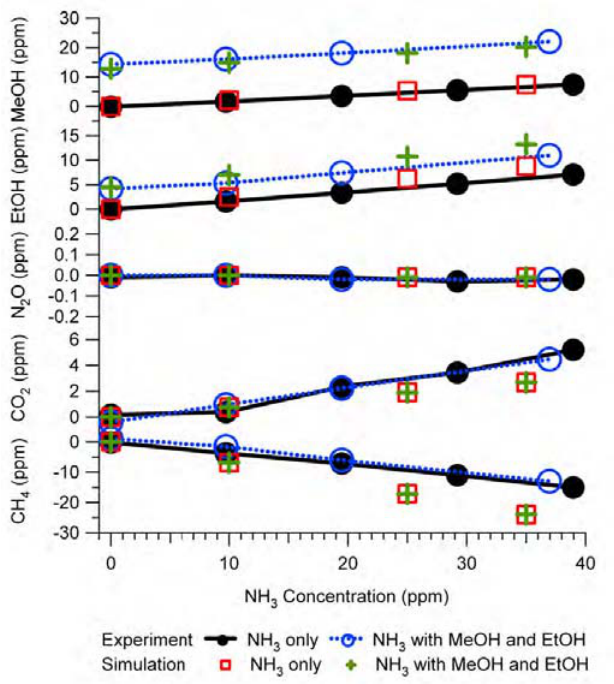
Figure 9. Interference of NH on target gases in Example #1 as a non-target gas. Black 3 solid lines with closed circles are experimental responses to NH other gases = 0 ppm), blue dash lines with open circles are experimental responses to NH in the presence of MeOH (12.8 ppm) and EtOH (4.5 ppm), red squares are results